Question: Sum up the contents of this chart in one sentence.
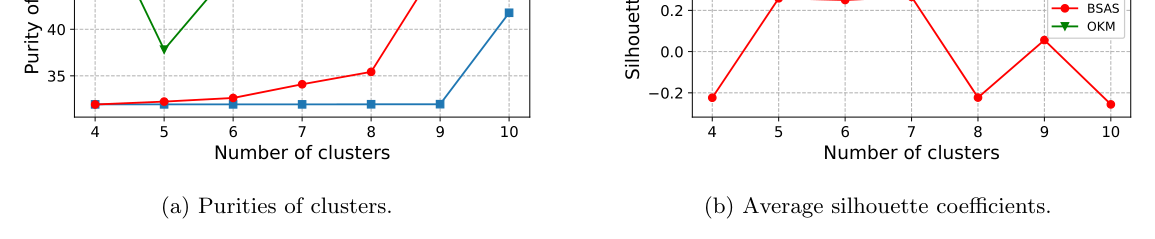
Answer: The relation between the number of clusters and the purity of clusters (a), respectively, the average silhouette coefficient (b). The online clustering algorithms were directly applied to the unlabeled dataset D and the streaming data S.